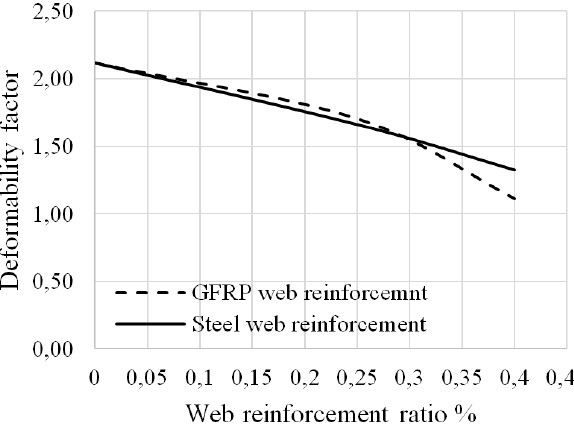
Figure 9: Relation between deformability factor and web reinforce- ment ratio